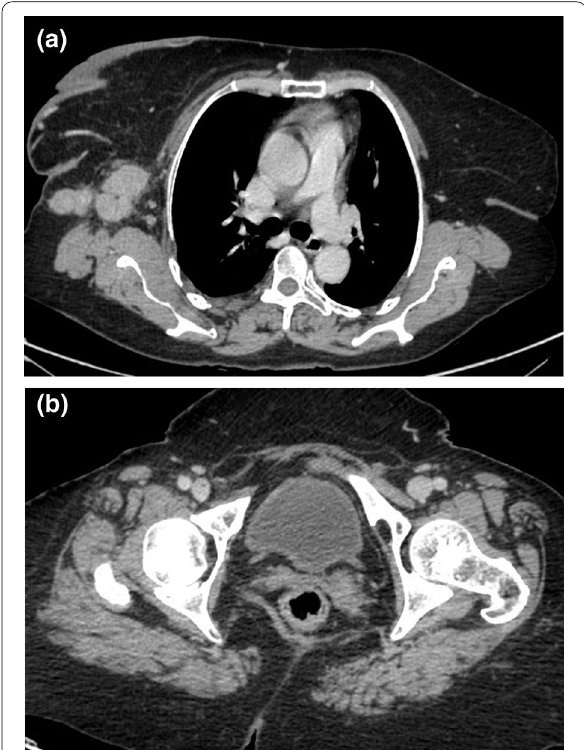
Fig. 4 a CT scan post contrast axial section: There are multiple enlarged lymph nodes in right axilla. Diffuse skin thickening is also visualized in the right breast. b CT scan post contrast axial section shows normal urinary bladder. No mass or wall